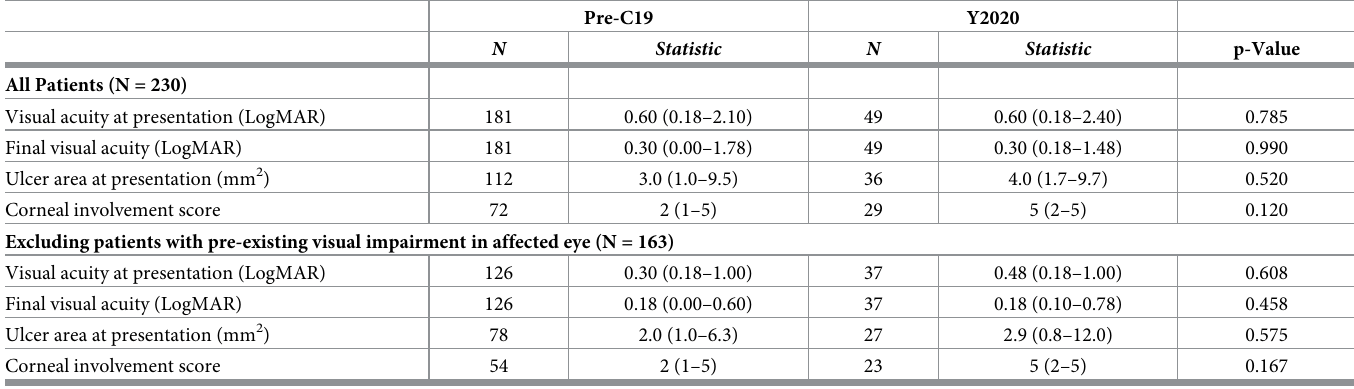
Table 2. Clinical assessments and outcomes.